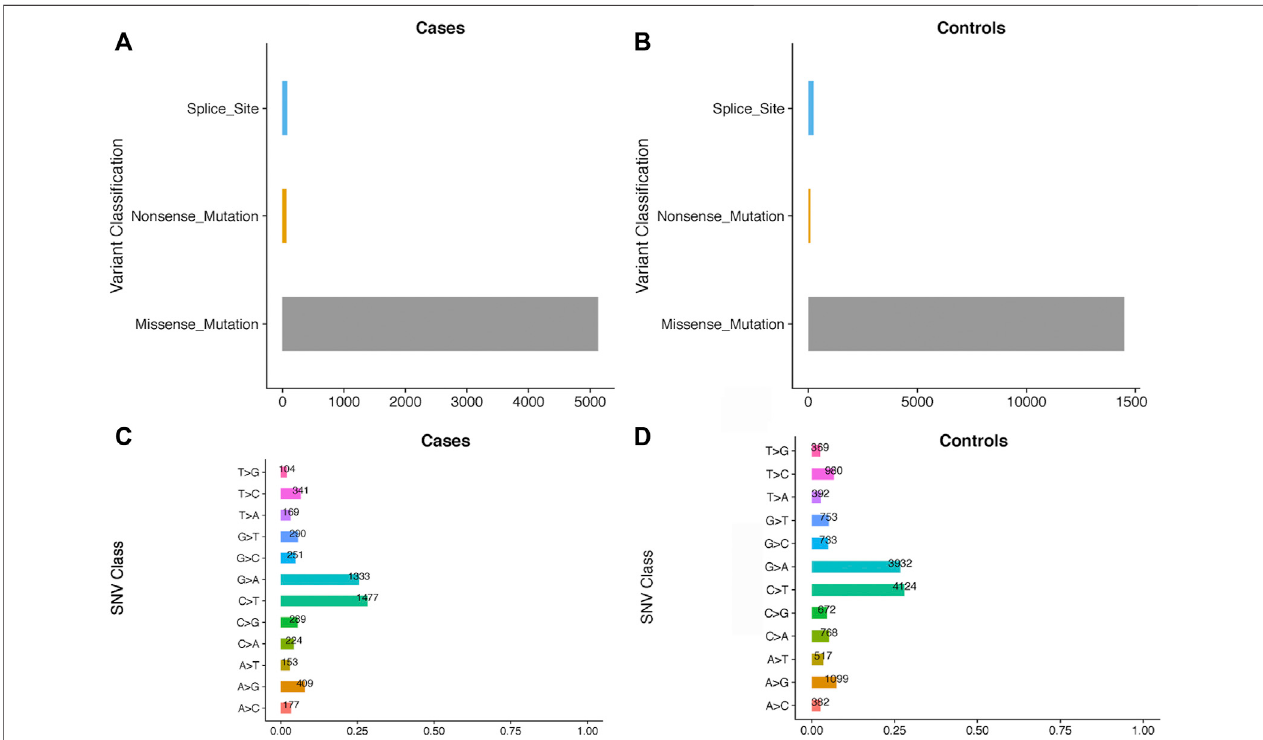
FIGURE 2 | The comparisons of the rare damaging variants between the PDA and control groups. The number of variants in each variant classi fi cation and SNV class between cases and controls are presented in (A – D) , respectively.